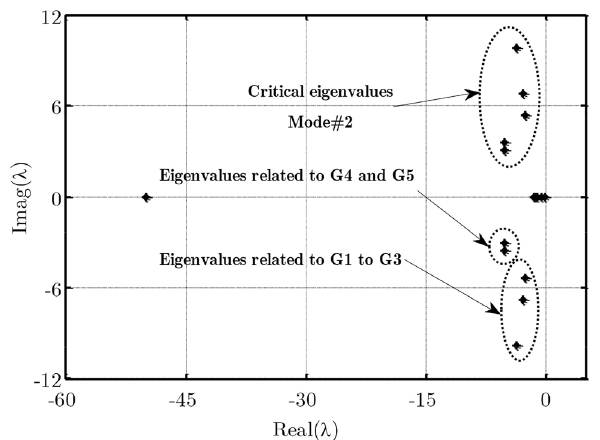
Fig. 4 Eigenvalues locus plot of IEEE 14-bus